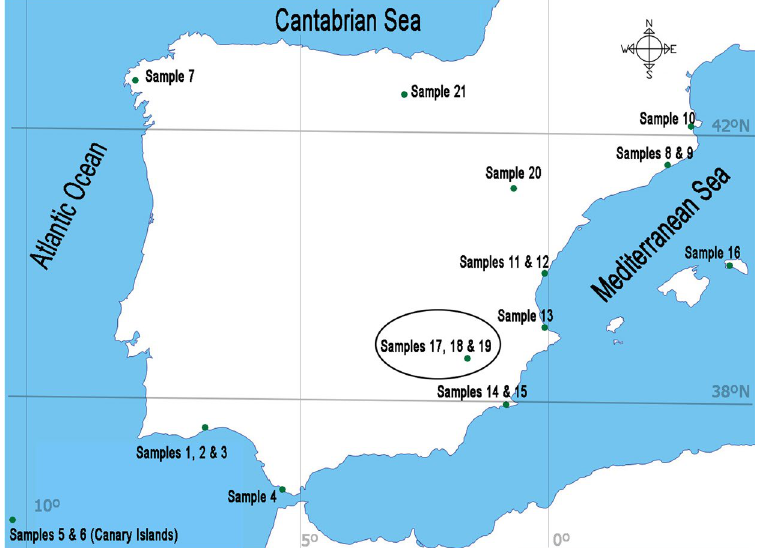
Figure 4. Map of Spain showing the sampling points. This Figure was done using Photoshop CS6 and was created modifying an image freely available at the following web: http://d-maps.com/carte.php?num_ car = 2190&lang = es. The maps on this page are free for any use, even